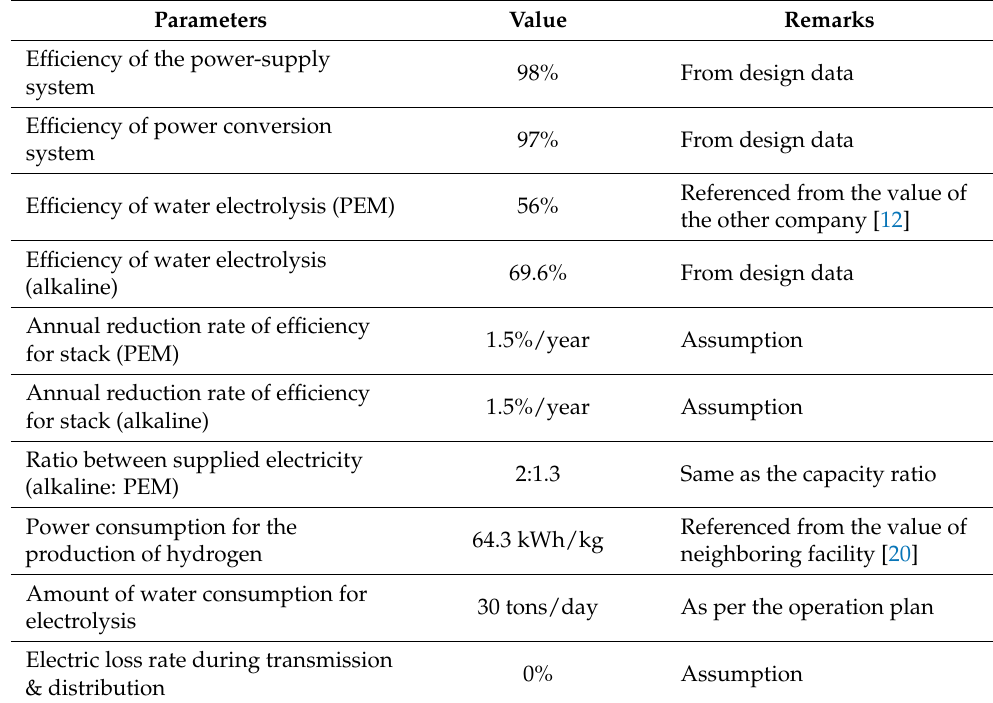
Table 5. Specification for facilities for the production of green